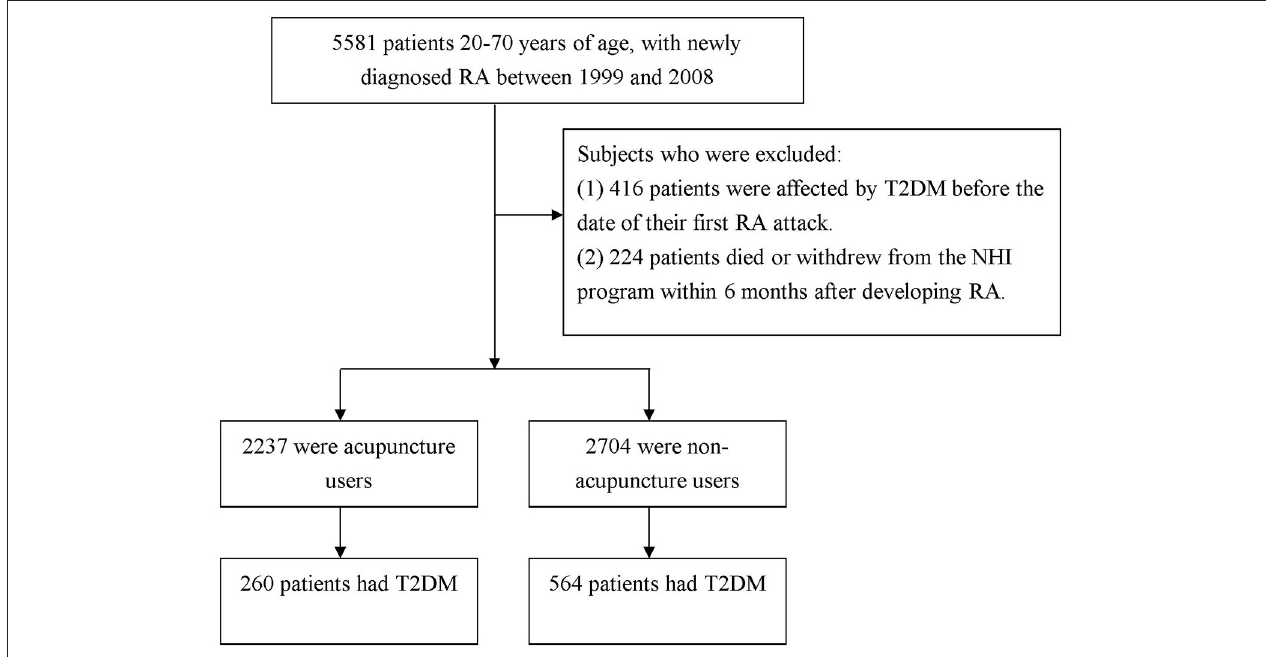
FIGURE 1 | Flowchart of selection and follow-up of study subjects.